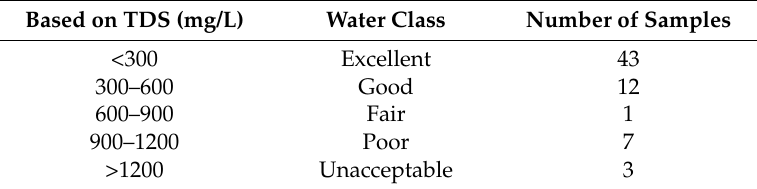
Table 5. Suitable of groundwater for drinking purpose on different